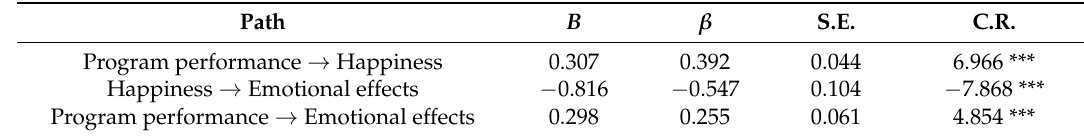
Table 7. Research model path coefficients.